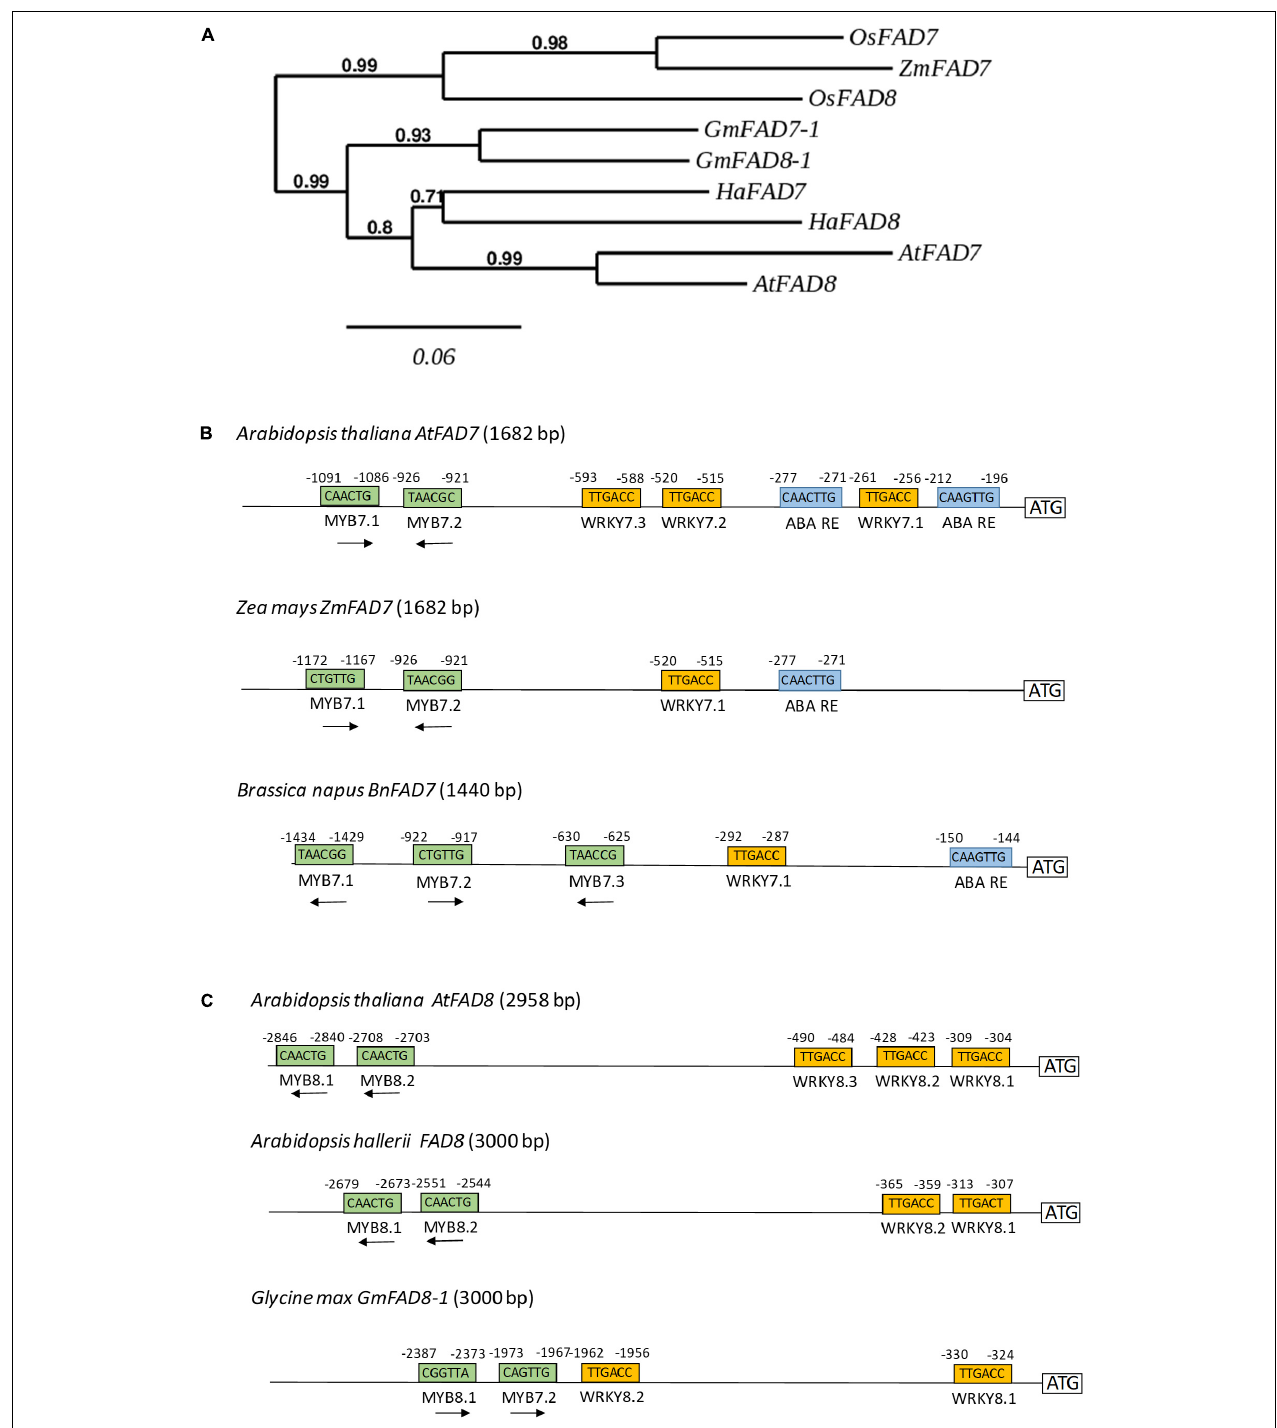
FIGURE 6 | In silico analysis of the presence of putative transcription factors identified in the AtFAD7 and AtFAD8 in promoter sequences from other plant species. (A) Phylogenetic tree of plastidial ω -3 fatty acid desaturases FAD7 and FAD8 from Arabidopsis, soybean, sunflower, maize and rice. Protein sequences obtained at the phytozome database were subjected to a CLUSTALW multiple alignment and phylogeny was analyzed by the PHYML software with bootstrap 500. (B) In silico comparative analysis of WRKY, MYB and ABA repression motifs in the FAD7 gene promoter from Zea mays ( ZmFAD7 , 1,682 bp) and Brassica napus ( BnFAD7 , 1,440 bp). (C) In silico comparative analysis of WRKY and MYB motifs in the FAD8 gene promoter from Arabidopsis hallerii ( AhFAD8 , 3,000 bp) and Glycine max ( GmFAD8-1, 3,000 bp). All genomic sequences were retrieved from Phytozome database. Relative position with respect to the ATG is indicated in small number in each